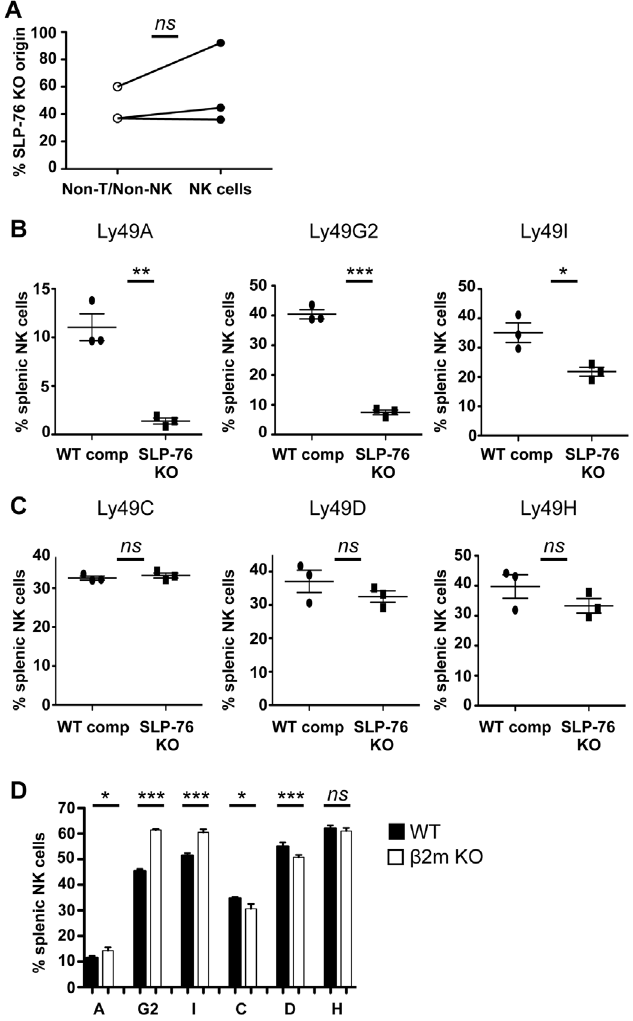
Fig 3. A subset of Ly49 receptors is regulated in an NK cell-intrinsic SLP-76-dependent manner. (A) The percentage of Non-T/NK cells and NK cells from WT competitor (CD45.2) was assessed in each mixed BM chimeric mouse. One representative experiment of four experiments is plotted ( n = 3 mice). ns = not significant by paired student ’ s t test. (B) The proportion of Ly49 receptor-expressing NK cells derived from WT or SLP-76 KO BM from mixed BM chimeras was assessed. One representative experiment of four experiments is shown as mean percent positive ± SEM of n = 3 mice. * p < 0.05, ** p < 0.01, *** p < 0.001, ns = not significant by paired student ’ s t test. (C) Ly49 receptor expression on splenic NK cells from WT (black bars) and β 2m KO (open bars) mice was assessed and represented as mean percent positive ± SEM of n = 10 mice. * p < 0.05, ** p < 0.01, *** p < 0.001, and ns = not significant by student ’ s t test. See S1 Data for raw